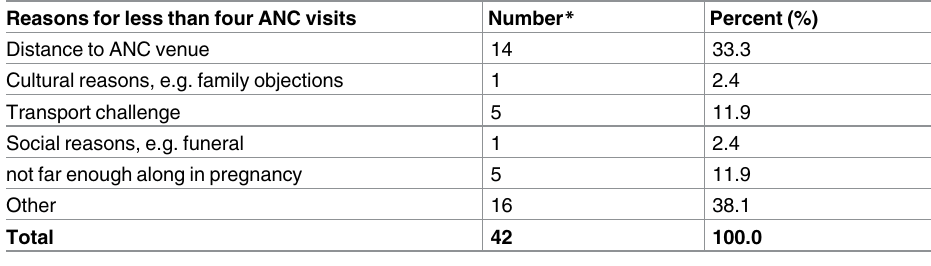
Table 4. Barriersto utilisation of ANC per expectant mothers.